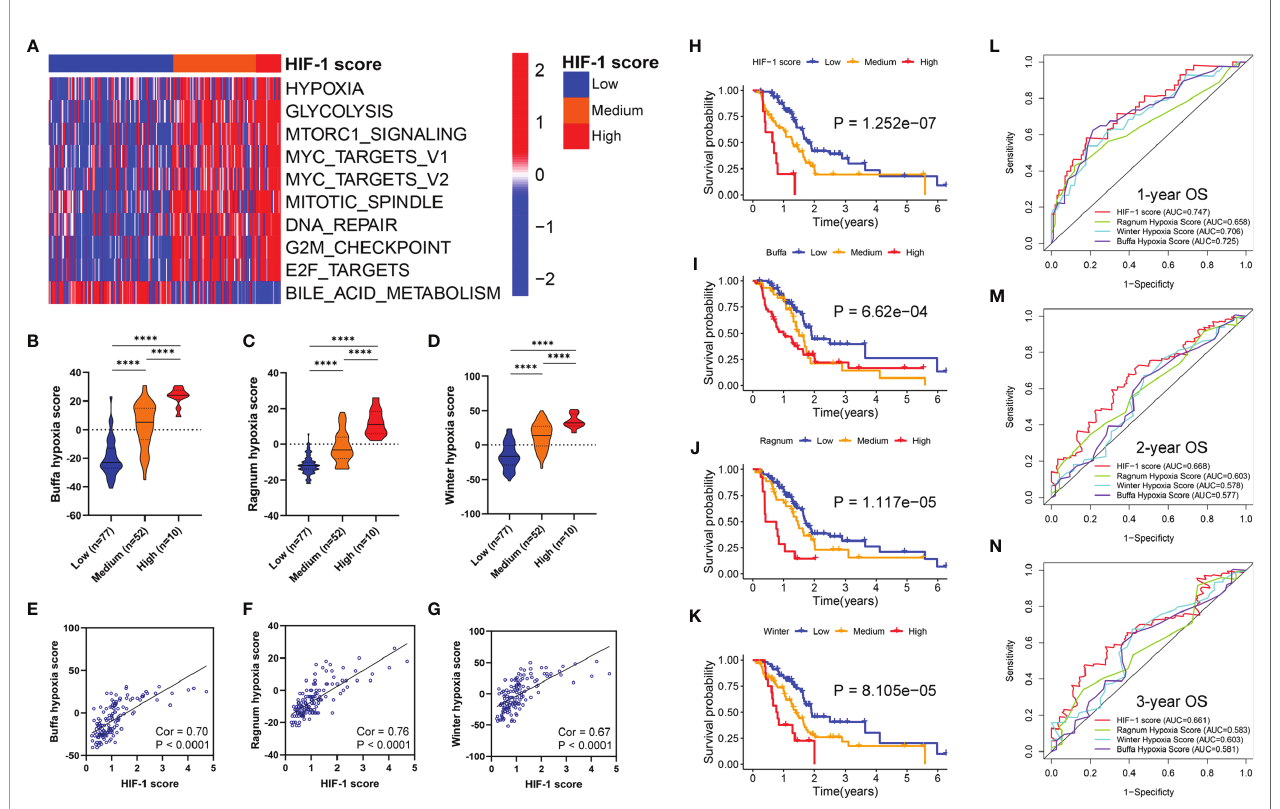
FIGURE 6 | Association between HIF-1 score and hypoxia status and oncologic biological processes in PDAC. (A) Heatmap to show the ten critical oncologic biological pathways intersected among the three HIF-1 clutters. (B – D) Stepwise scores from HIF-1 score low to high group based on the Buffa hypoxia, Ragnum hypoxia score, and Winter hypoxia score system. (E – G) HIF-1 score was signi fi cantly correlated with Buffa hypoxia, Ragnum hypoxia score, and Winter hypoxia score system. (H – K) KM survival curves for OS of patients with PDAC according to the HIF-1 score system, Buffa hypoxia, Ragnum hypoxia score, and Winter hypoxia score system in TCGA PDAC cohort. (L – N) ROC curve analysis for 1-, 2-, and 3-year OS prediction based on the HIF-1 score system, Buffa hypoxia, Ragnum hypoxia score, and Winter hypoxia score system in TCGA PDAC cohort. PDAC, pancreatic ductal adenocarcinoma; KM, Kaplan-Meier; OS, overall survival; TCGA, the Cancer Genome Atlas; ROC, the receiver operating characteristic curve. ****P value <